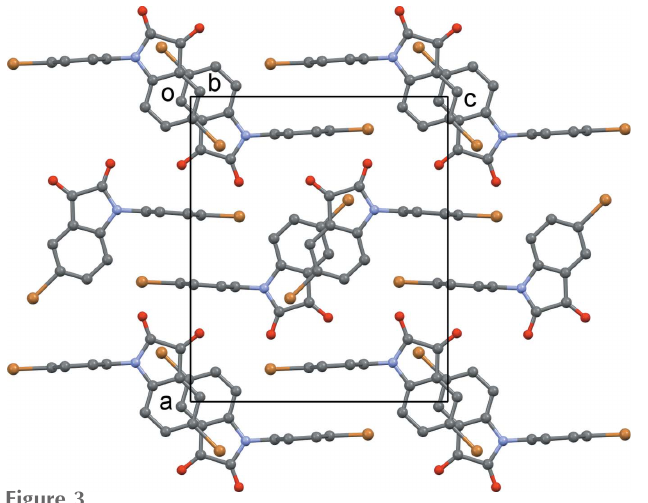
Intermolecular interactions (dashed lines) in a layer of the structure.